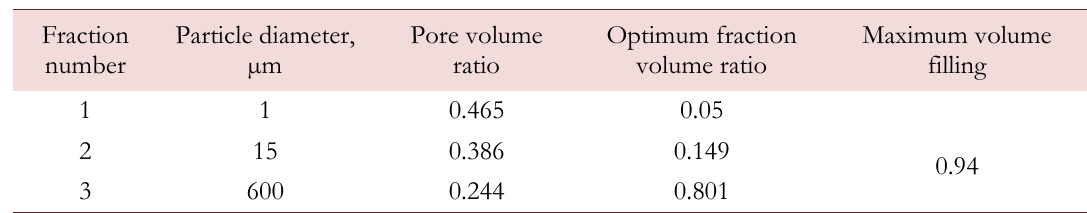
Т able 2: Parameter values of mixtures of three silica fractions.